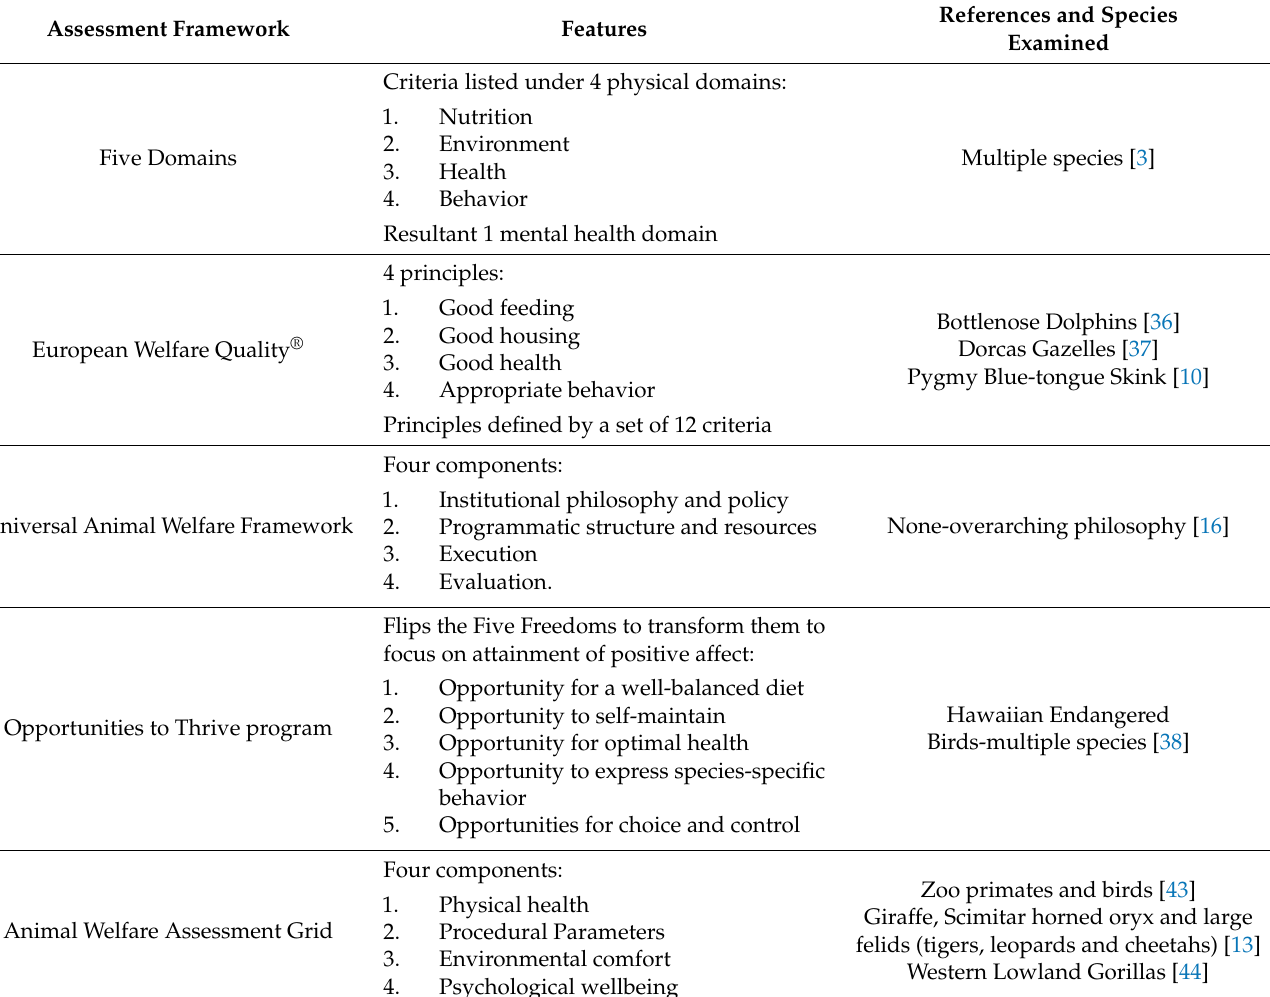
Table 1. Summary of welfare assessment frameworks and protocols that have been applied to zoos with references for their use in zoological